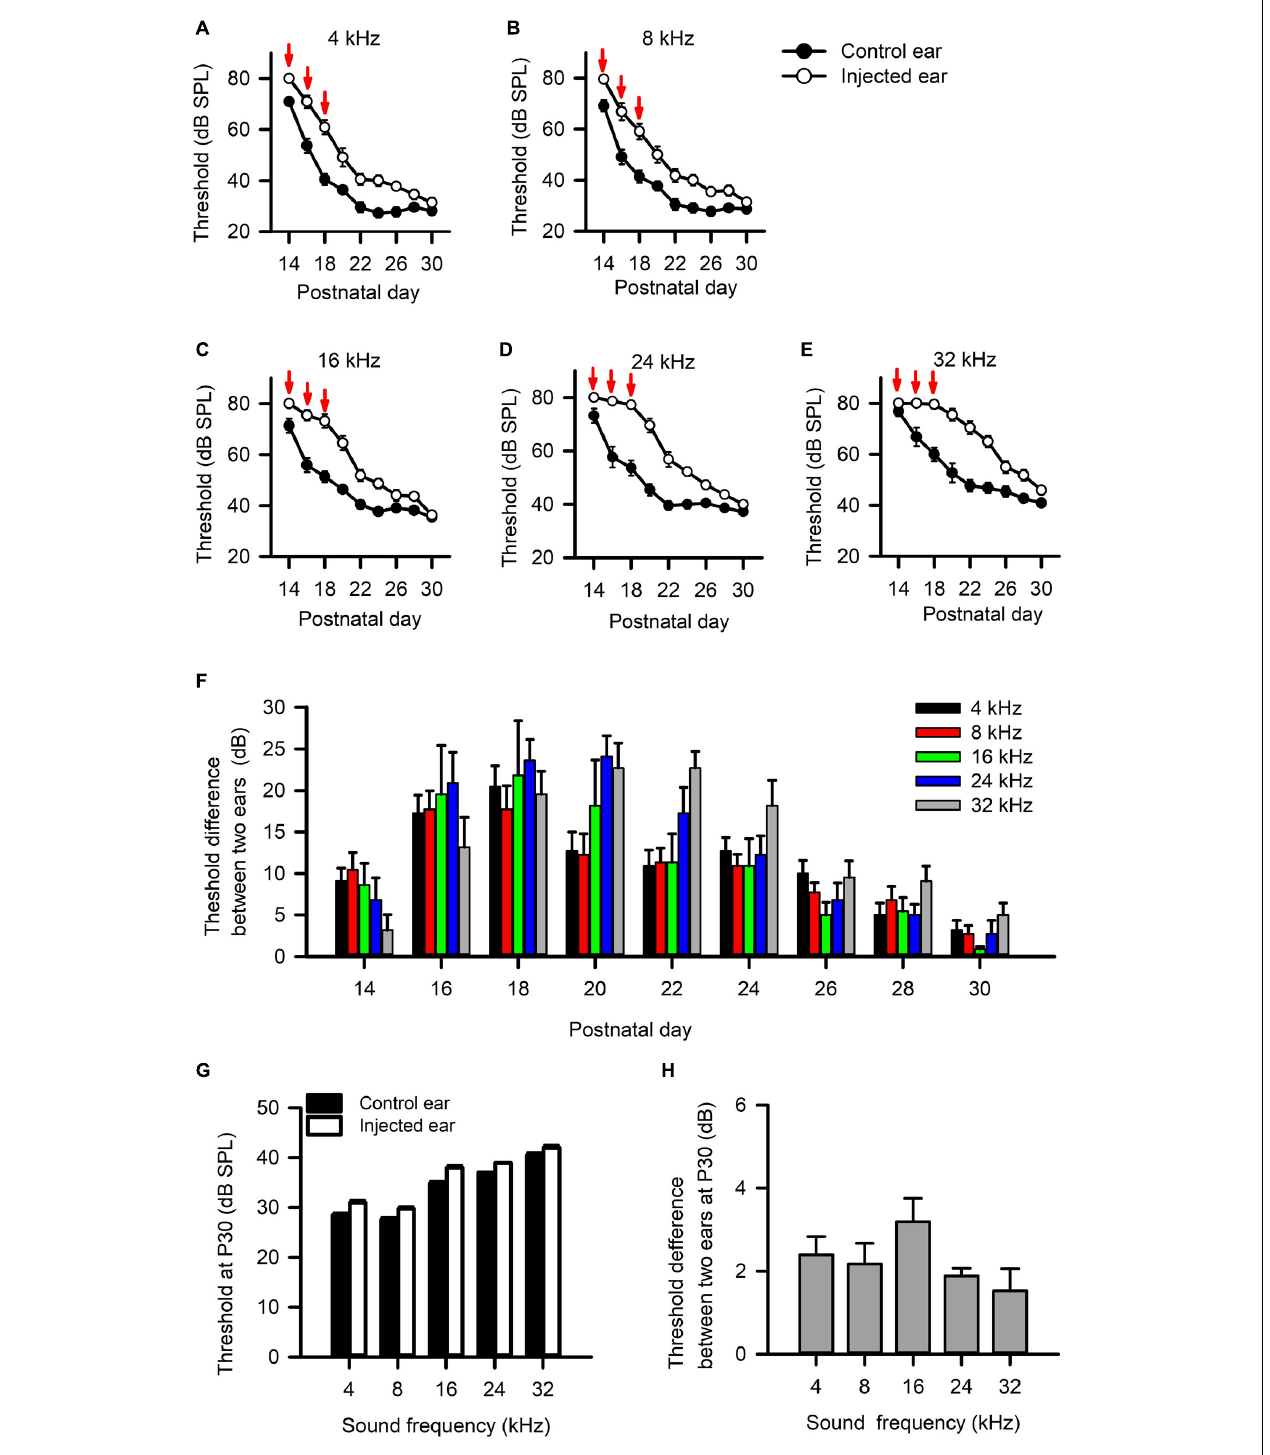
FIGURE 9 | The effects of intratympanic poloxamer injections on the hearing threshold of the injected ear determined from the wave I of auditory brainstem response (ABR). (A–E) The response thresholds for ABR wave I elicited with tone bursts at the frequencies of 4 kHz (A) , 8 kHz (B) , 16 kHz (C) , 24 kHz (D) , and 32 kHz (E) , respectively. The intratympanic poloxamer injections (red arrows) were made on P14, P16, and P18 in the right ear (the injected ear). The control ear was the intact left ear. (F) The differences in ABR wave I threshold, i.e., the threshold of the injected ear minus the threshold of the control ear. These data are determined from 11 rats. (G) The ABR wave I thresholds for both the injected ear and the control ear determined at P30 ( n = 60 rats). (H) The differences in ABR wave I threshold between the injected ear and the control ear determined at P30 ( n = 60 rats).